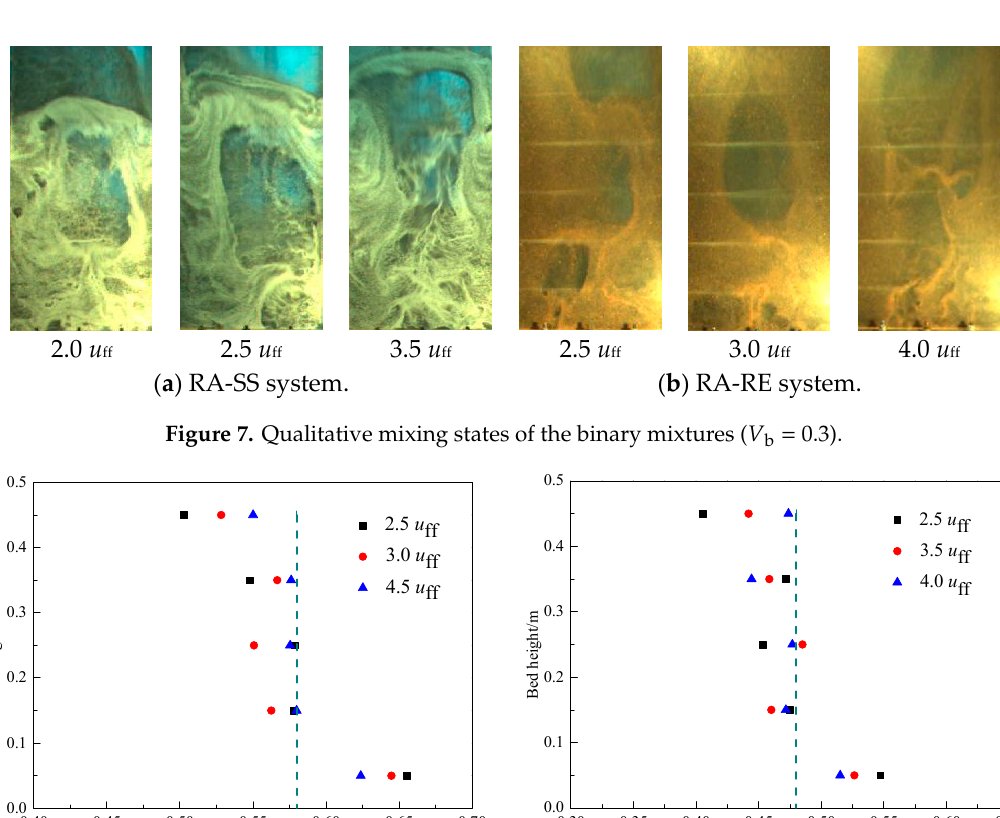
( c ) Figure 5. Three different initial packing conditions. ( a ) RA on top, ( b ) RA on bottom, and ( c ) complete mixed state. 0.40